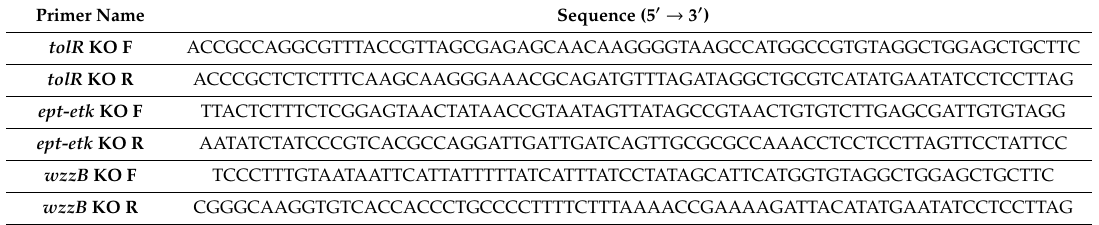
Table 2. List of primers used in this